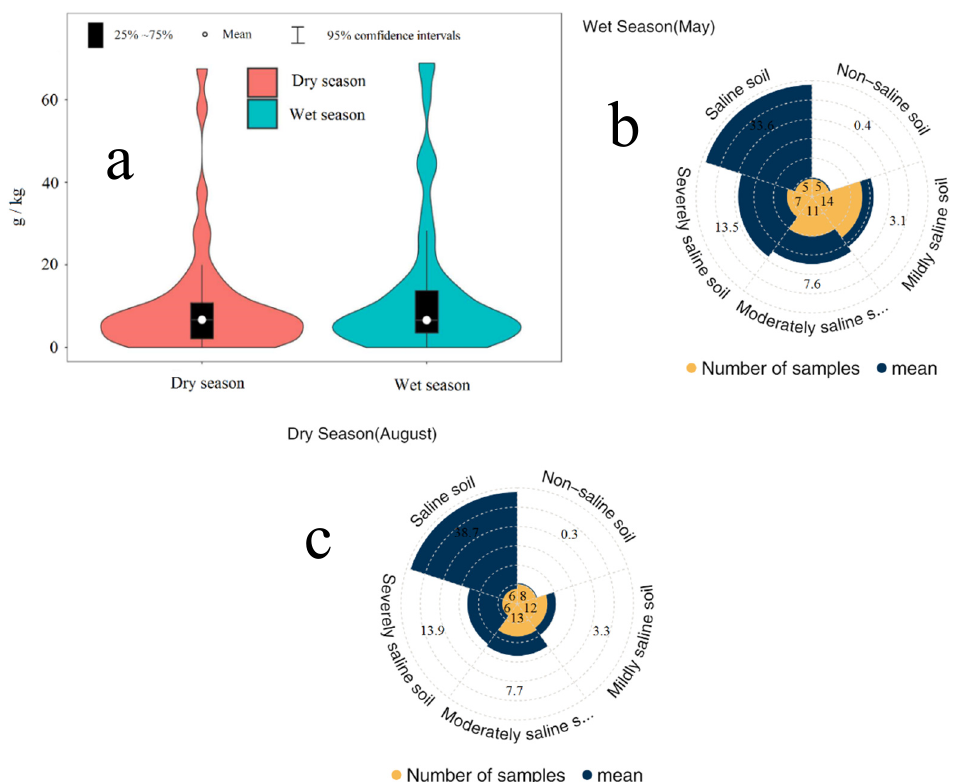
Figure 3. Description of sampling point data distribution of the salt content of soil surface: ( a ) violin plots showing the descriptive statistics of soil salinity for the wet and dry seasons; and ( b , c ) pie chart showing the distribution of salt values at different levels (five levels).